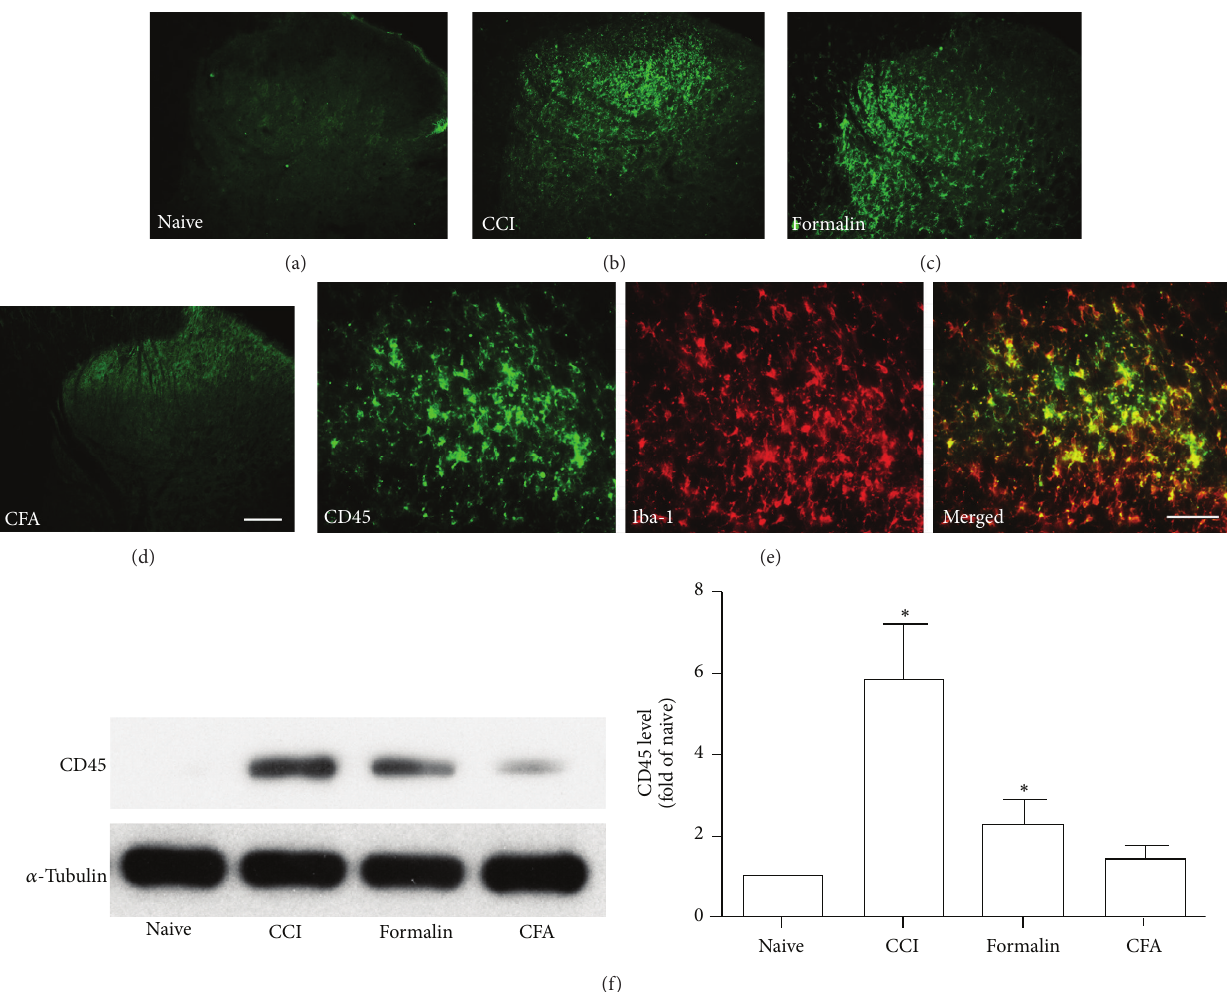
Figure 2: Significant increased expression of CD45 was found in the ipsilateral side of spinal cord of CCI and formalin-injected rats and weak expressed in CFA-injected rats ((a)–(d); Scale bar, 100 𝜇 m). Double labeling with Iba-1 confirmed that the cell expressing CD45 is microglia ((e); Scale bar, 50 𝜇 m). Representative bands and quantification of western blot analysis (f) showed significantly increased CD45 protein level in the lumbar spinal cord after CCI injury and formalin injection, not after CFA